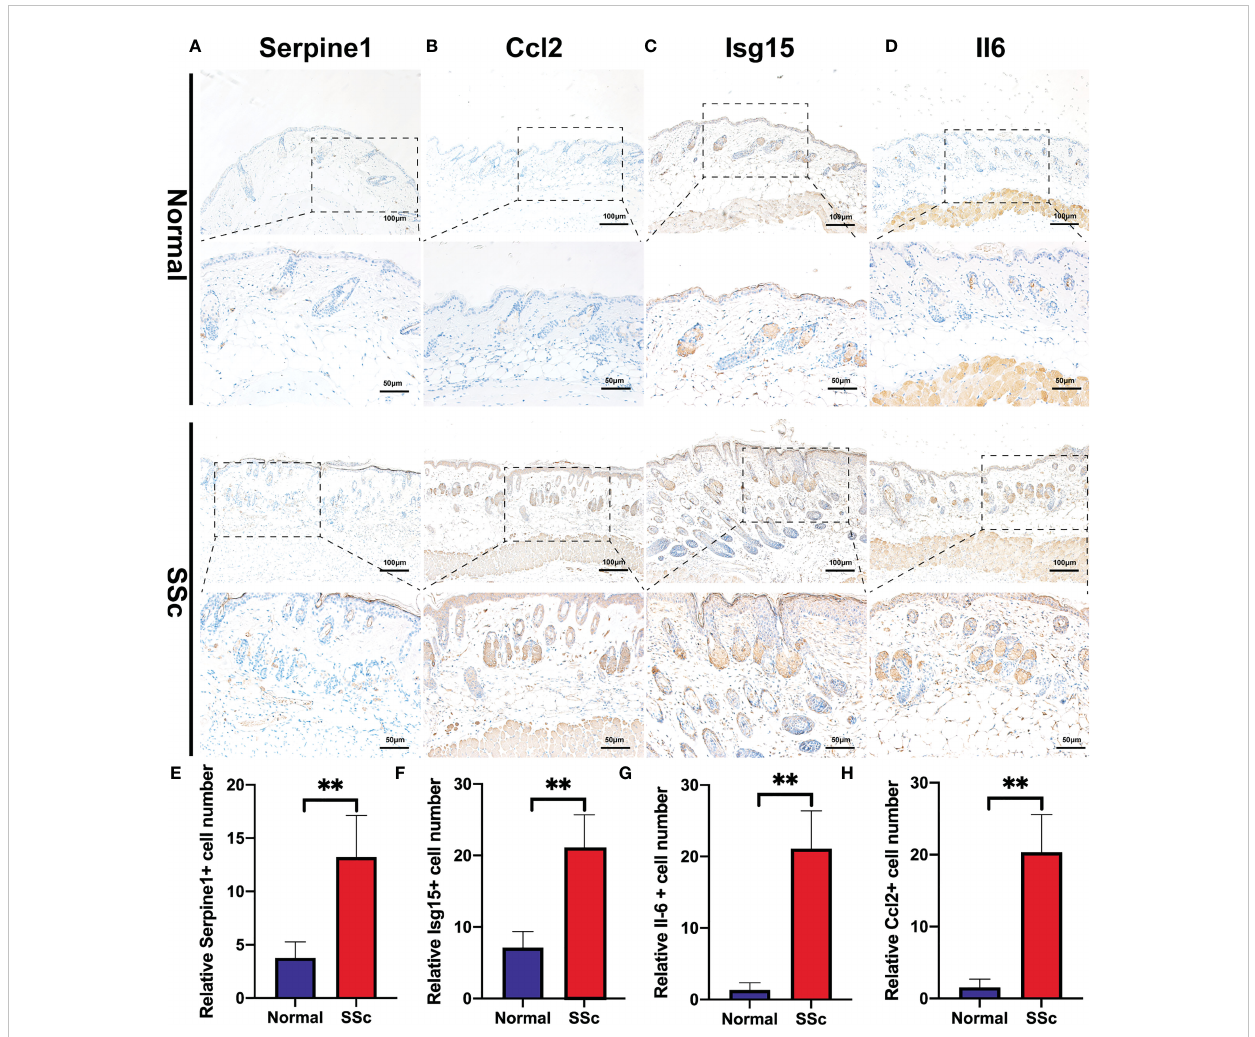
FIGURE 5 Immunohistochemistry of bleomycin induced scleroderma mouse model and normal control. (A-D) Representative images of Serpine1-, Ccl2-, Isg15-, and Il6 -positive cells detected by immunohistochemical staining. (E-H) Quantitative analysis of Serpine1-, Ccl2-, Isg15- and Il6 -positive cell numbers. **P < 0.01.